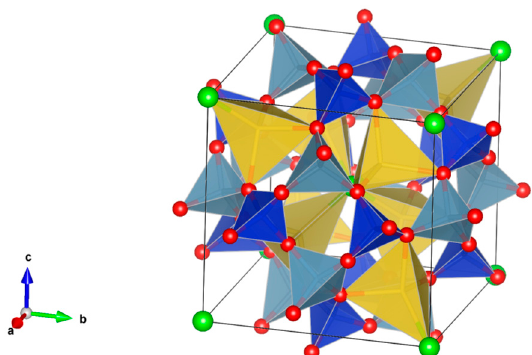
Figure 19. Sodalite.group minerals. (Mn 4 [Be 3 Si 3 O 12 ]S / (Fe 4 [Be 3 Si 3 O 12 ]S) / (Zn 4 [Be 3 Si 3 O 12 ]S) / (Ca,Na) 6 [Al 6 Si 6 O 24 ]((Ca,Na),S,SO 4 ,Cl) x